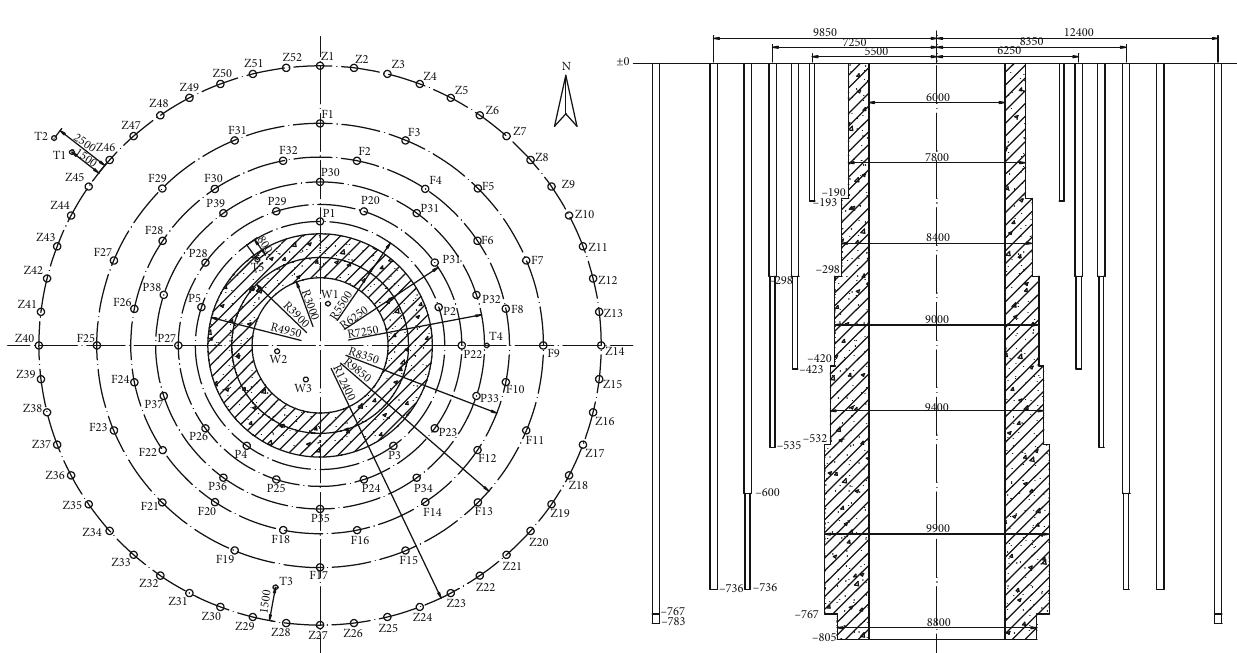
Figure 5: Layout of frozen boreholes in the west air shaft of Zhaogu No. 2